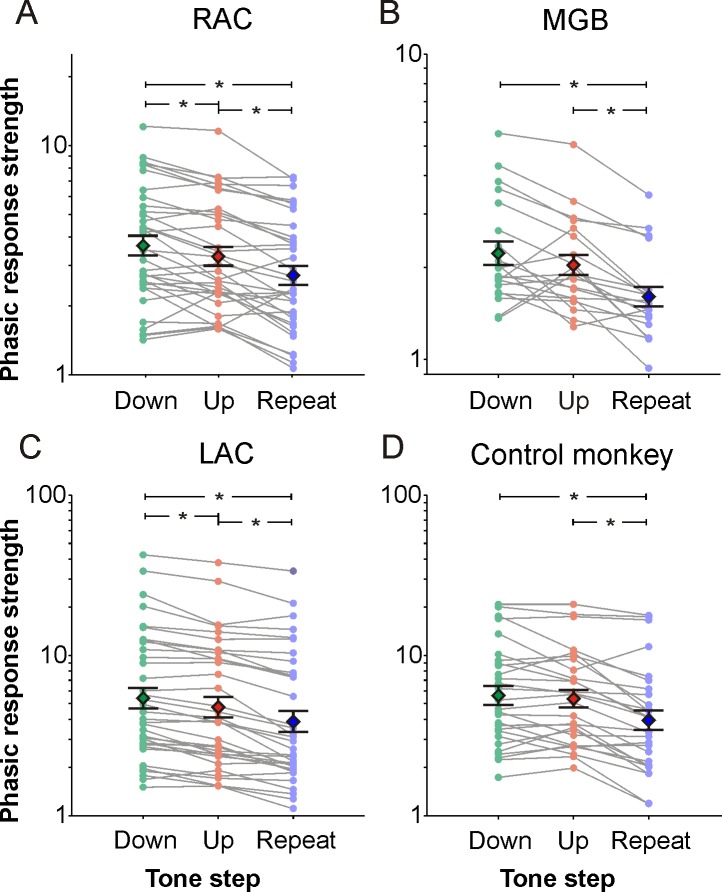
Similar preferences for downsteps in three regions of the auditory forebrain.(A) Distributions of phasic response strengths for downsteps, upsteps, and frequency repeats of 34 multiunits in right auditory cortex (RAC). Data from the same multiunit are connected by lines. The diamonds represent mean logarithmic strengths and the whiskers represent standard errors. Asterisks mark significant differences between pairs of tone steps (t-tests, p < 0.01). Phasic response strength was defined as the maximal normalized firing rate (see lower panels in Fig 3). (B) Distributions of phasic response strengths for the three tone steps of 20 multiunits in right medial geniculate body (MGB). (C) Distributions of phasic response strengths for the three tone steps of 36 multiunits in left auditory cortex (LAC). (D) Distributions of phasic response strength for the three tone steps of 28 multiunits in the LAC of a control monkey who was naive to the categorization task and only passively exposed to the tone sequences.